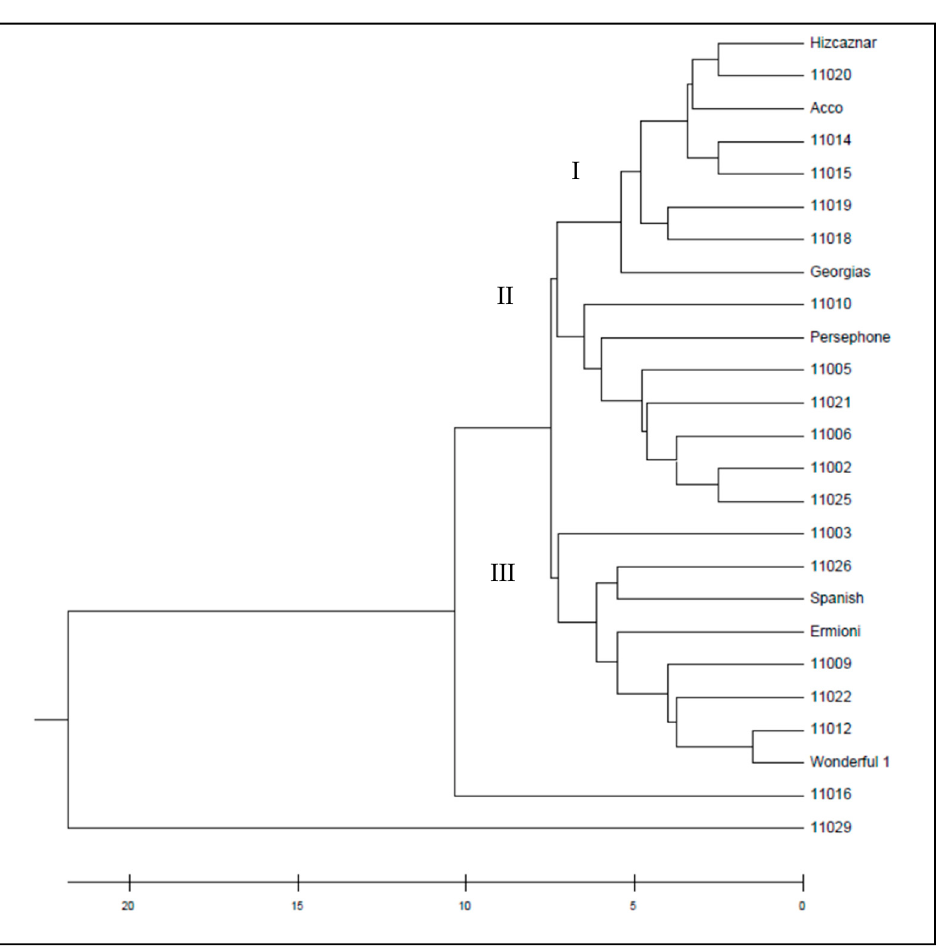
Figure 4. UPGMA dendrogram of the studied 26 pomegranate genotypes based on 9 ISSR markers. The dendrogram obtained from the ISSR markers by UPGMA method grouped the pomegranate cultivars into three wider clusters (Figure 4), while the UPGMA dendrogram resulted from the SCoT markers grouped the cultivars into eight smaller clusters (Figure 5). Similarities and dissimilarities between the two dendrograms can be easily detected. Hicaznar, Georgias, 11019 and 11018 belong to the same cluster in both dendrograms. Cvs Ermioni, 11009, 11026 and 11022 may belong to the same cluster according to the ISSR dendrogram but according to the SCoT markers two different clusters are formed that are very close to each other. The dendrogram obtained from the combined distance matrix of ISSR and SCoT markers, grouped the pomegranate genotypes into three clusters (Figure 6). Cultivars 11012, Wonderful 1, 11009, Ermioni, 11026, 11022, 11003, and Spanish form the first cluster. The second cluster contained 11021, 11005, Persephone, 11002, 11010, 11006, 11025, while the third cluster contained Georgias, 11019, 11018, 11015, 11014, Hicaznar, Acco, and 11020. Accessions 11016 and 11029 were not included in any